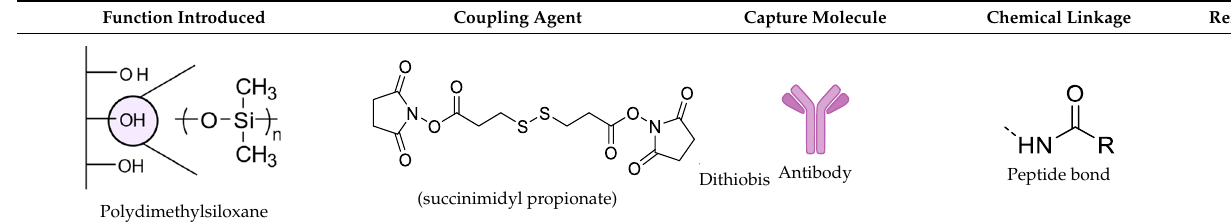
Table 2. Methods reported for the covalent conjugation of capture biomolecules on insulating lay- ers. R: Capture Table 2. Cont.